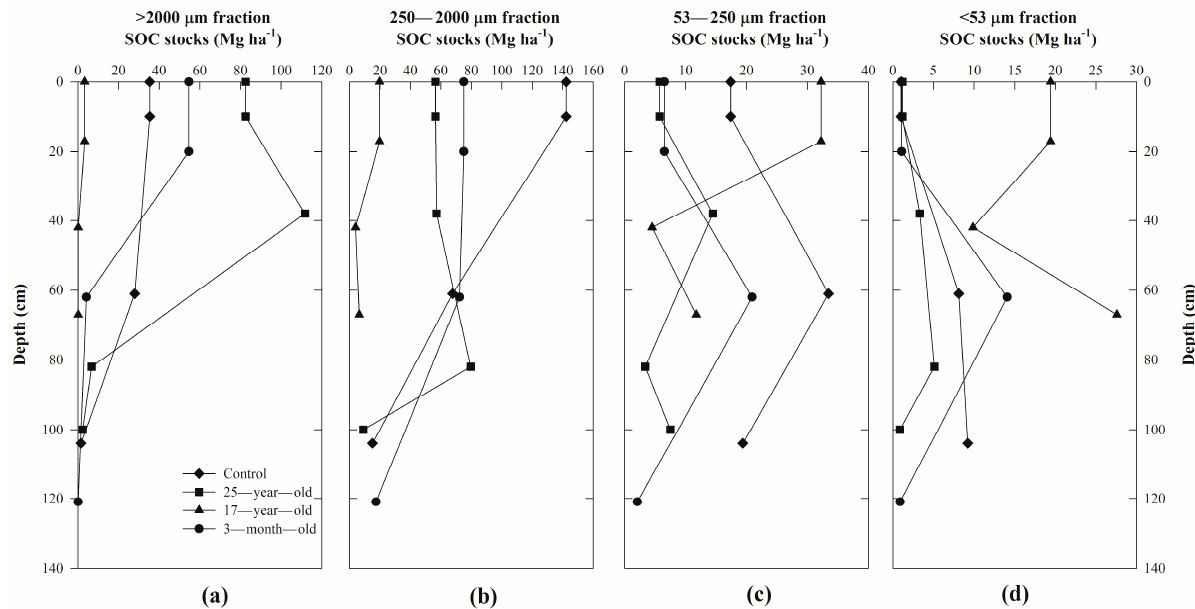
Figure 3. Changes of water stable aggregates (WSA) associated SOC (WSA-SOC) stocks with depth including ( a ) >2000 µ m fraction, ( b ) 250–2000 µ m fraction, ( c ) 53–250 µ m fraction, and ( d ) < 53 µ m fraction after a wildfire in mineral horizons.